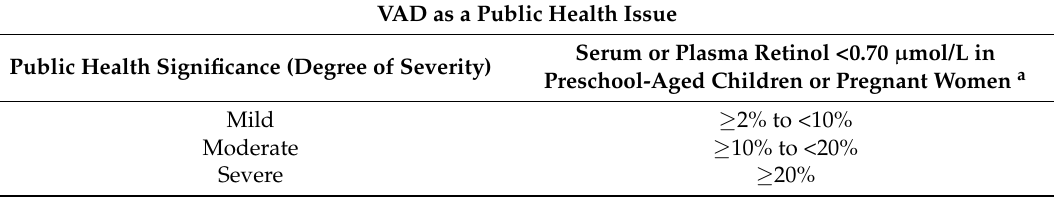
Table 1. Prevalence ranges of vitamin A deficiency (VAD) in the population and their level of public health